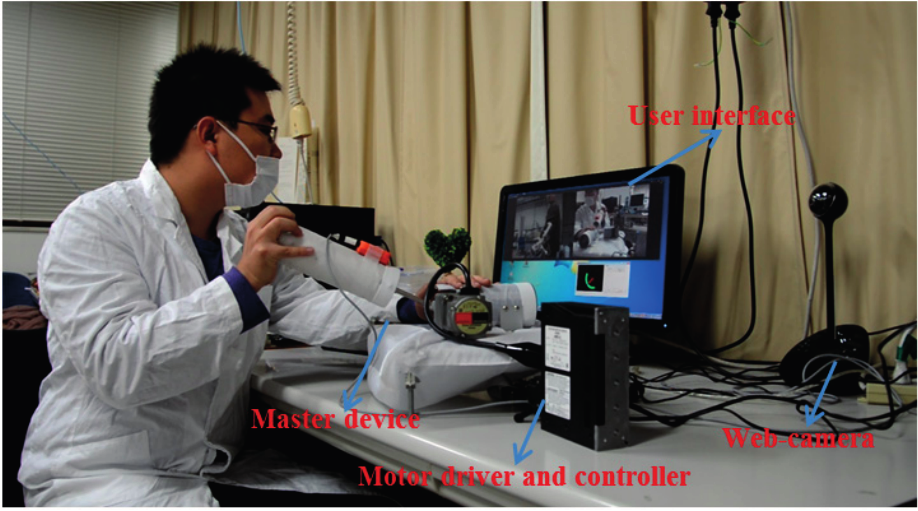
Figure 11. Master side of the implemented